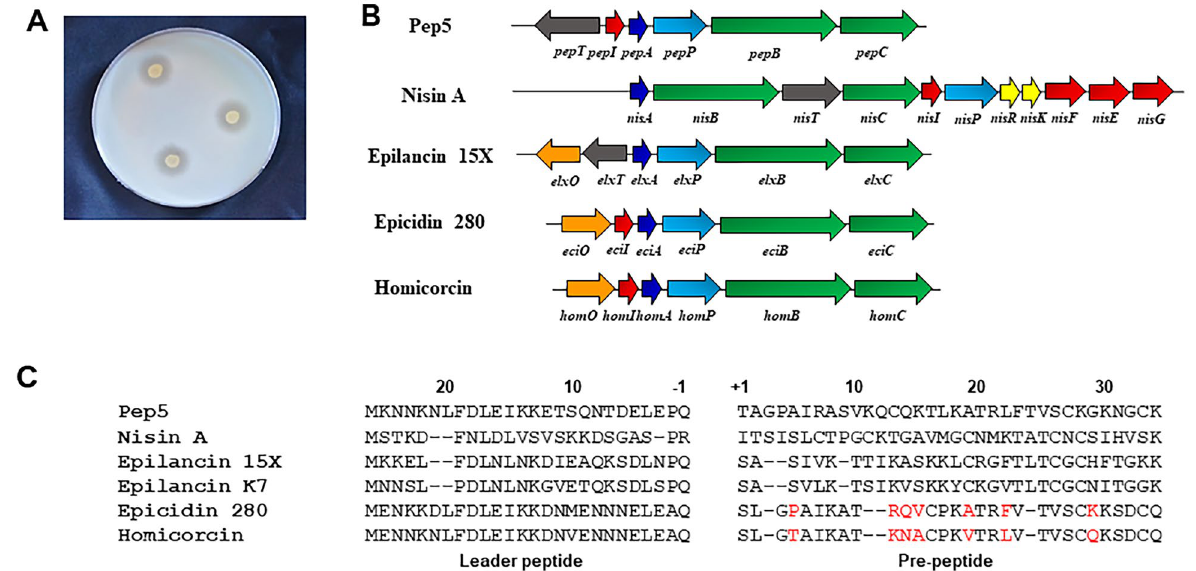
Figure 1. Prediction of the homicorcin gene cluster and comparison with other class I lantibiotics. ( A ) Inhibitory activity of Staphylococcus hominis strain MBL_AB63 (activity overlay assay against Staphylococcus aureus SG511). ( B ) Biosynthetic gene cluster of different class I lantibiotics. Homicorcin gene cluster was predicted using BAGEL 4.0 ( homO : 3-oxoacyl-[acyl-carrier-protein] reductase gene; homI : immunity gene; homA : homicorcin gene; homP : protease gene for leader peptide cleavage; homBC : genes for post translational modification enzyme). ( C ) Comparisons between the peptide sequences of homicorcin and other class I lantibiotics (residues not similar to Epicidin 280 are shown in red).